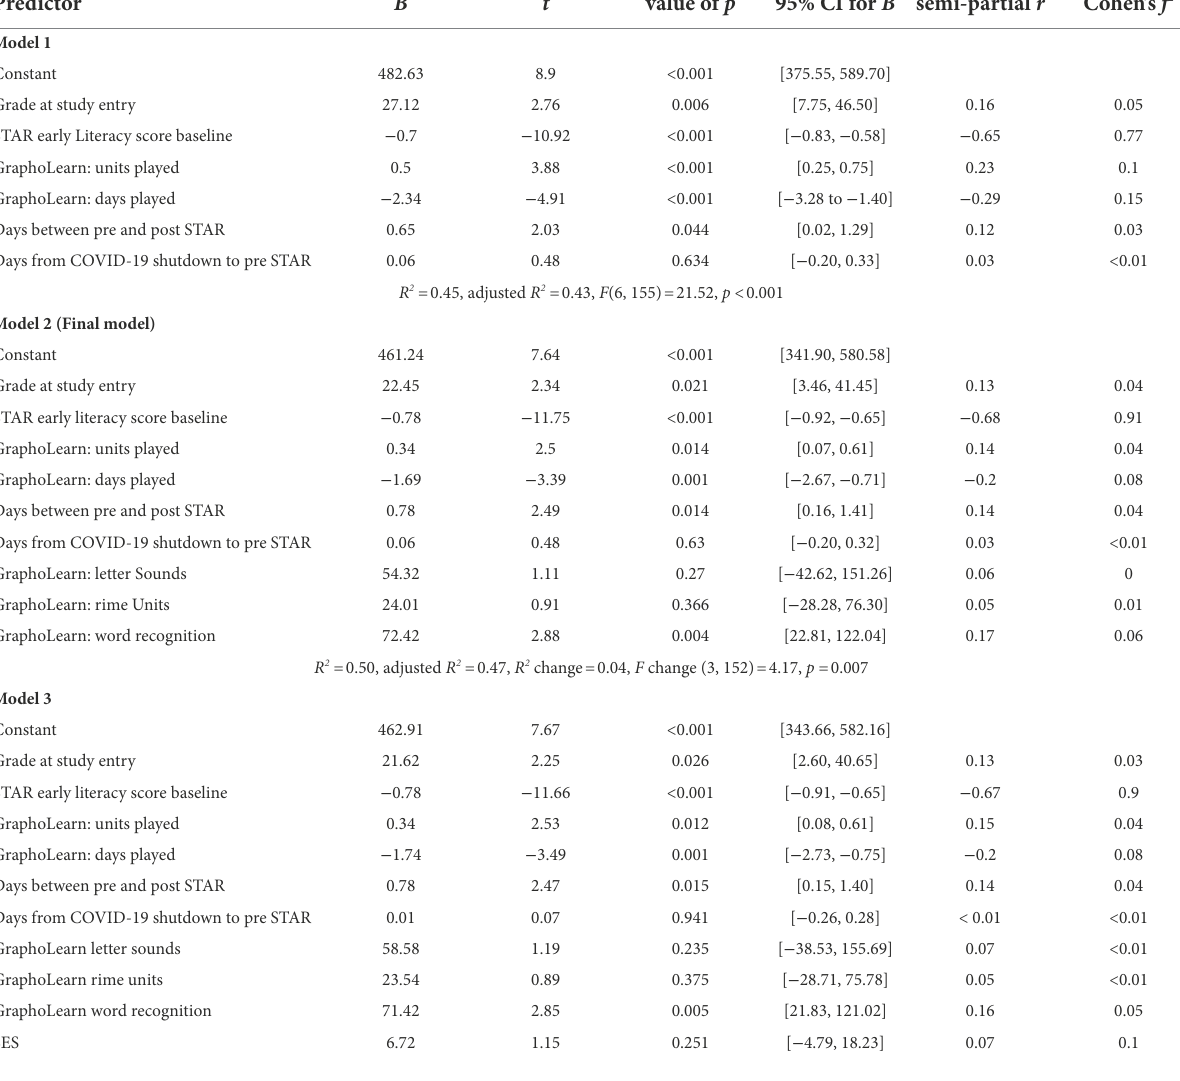
TABLE 3 Multiple regression analyzes predicting STAR Early Literacy score difference.